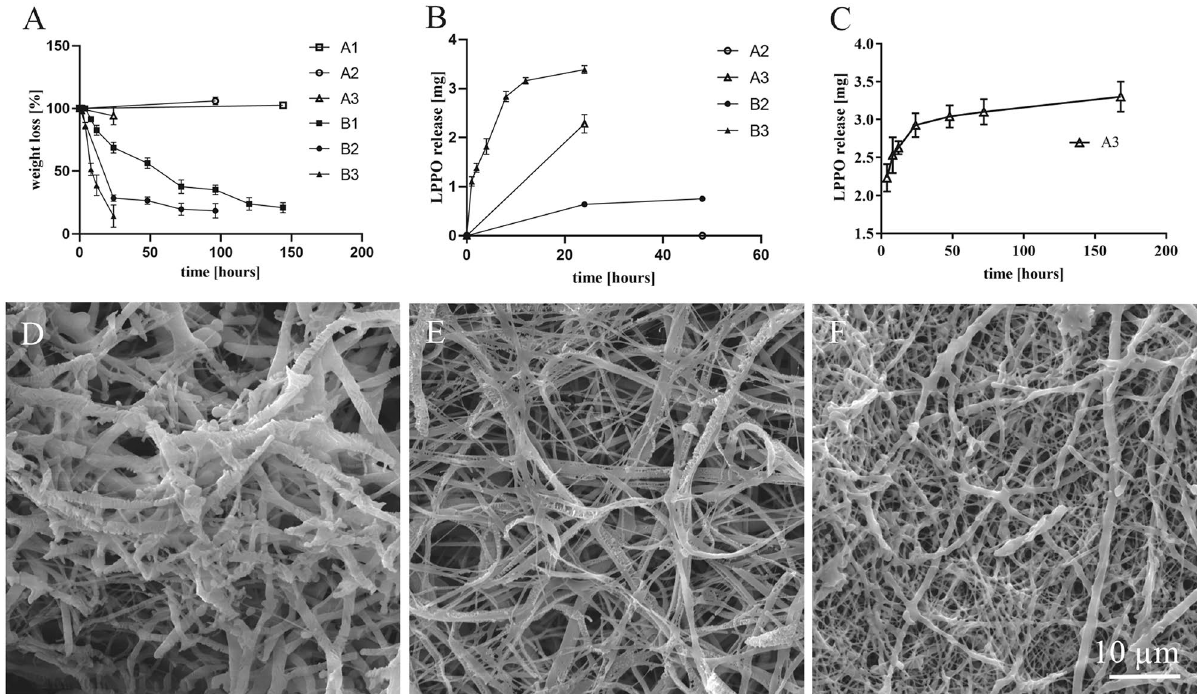
Figure 2. Graphs representing the degradation of NANO and cumulative release of LPPO ( A – C ) and SEM images of the materials ( D – F ). ( A ) weight loss of nanomaterials during incubation (A1–A3 without enzyme, B1–B3 in the presence of enzyme), ( B ) LPPO release in phosphate buffer saline within 1 week, ( C ) LPPO release during incubation (A2–A3 without enzyme, B2–B3 in the presence of enzyme), and. For ( B ) and ( C ): the total amount of LPPO released from 50 mg samples. A1/B1 NANO-LPPO0%, A2/B2 NANO-LPPO2%, A3/B3 NANO-LPPO10%. ( D ) SEM image of NANO at the 4th day of degradation, ( E ) SEM image of NANO-LPPO2% at the 3rd day of degradation, ( F ) SEM image of NANO-LPPO10% at the 1st day of degradation, Samples are labeled according to Table 1).